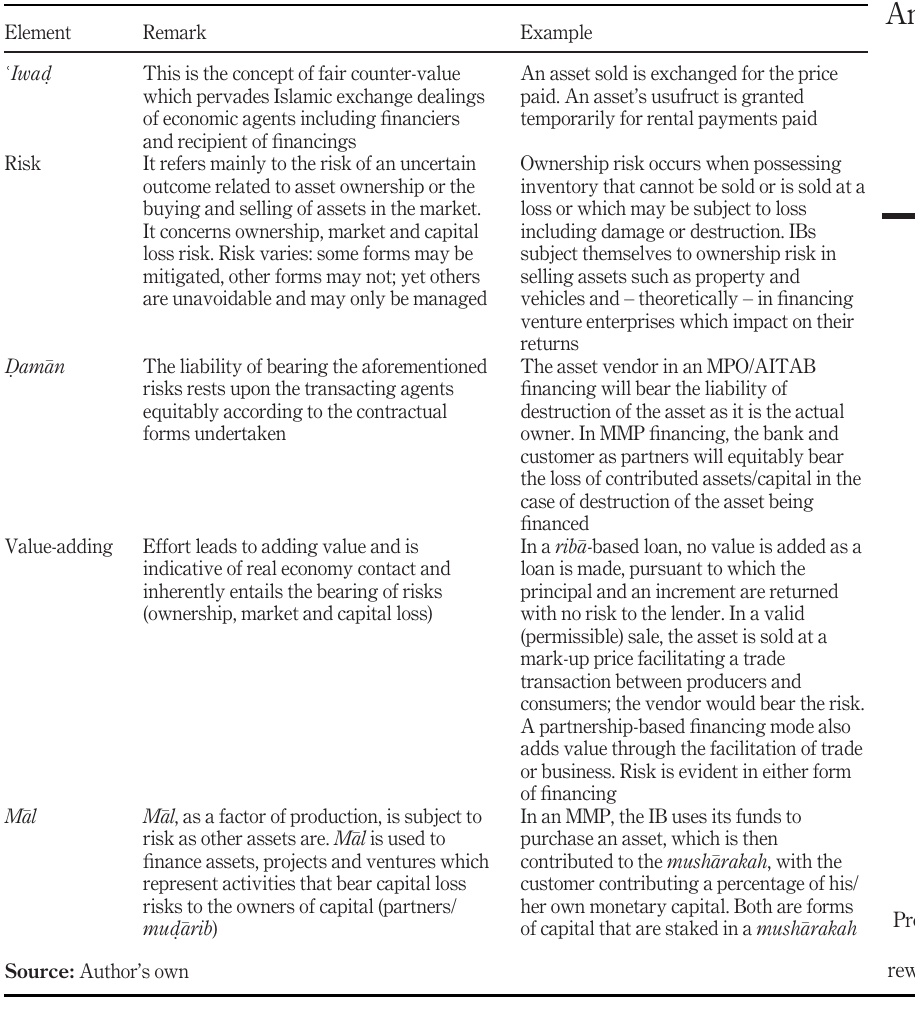
Table 1. Proposed